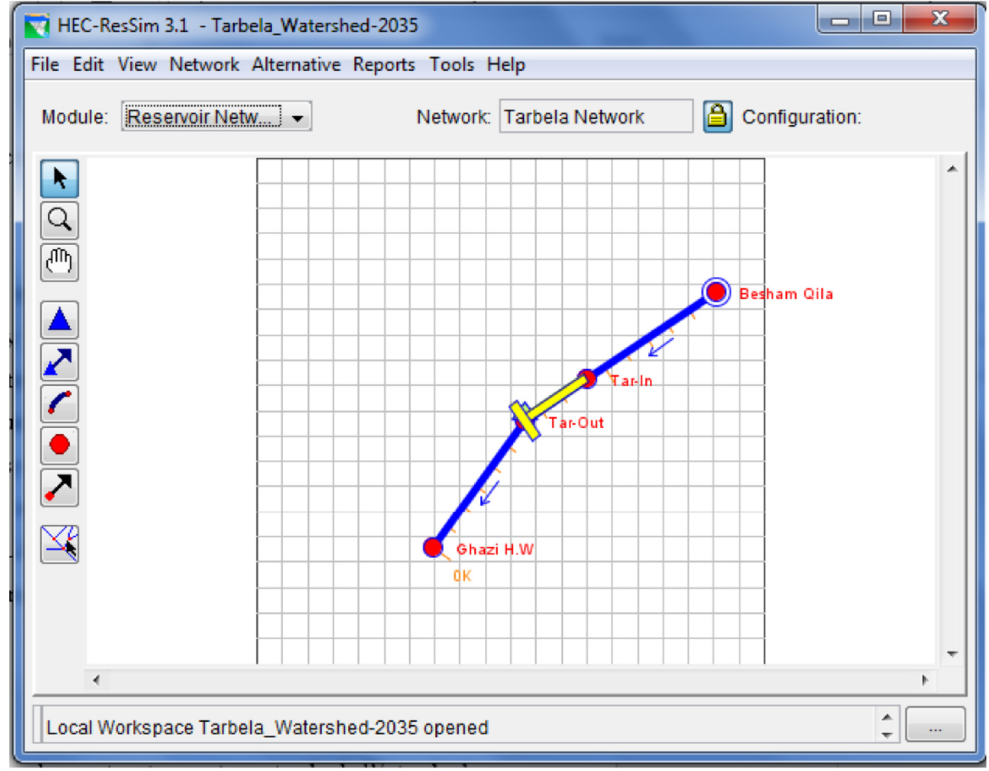
Figure 15. Input Screen of HEC-ResSim for Modelling Tarbela.(Blue line shows river reach while yellow part shows Tarbela